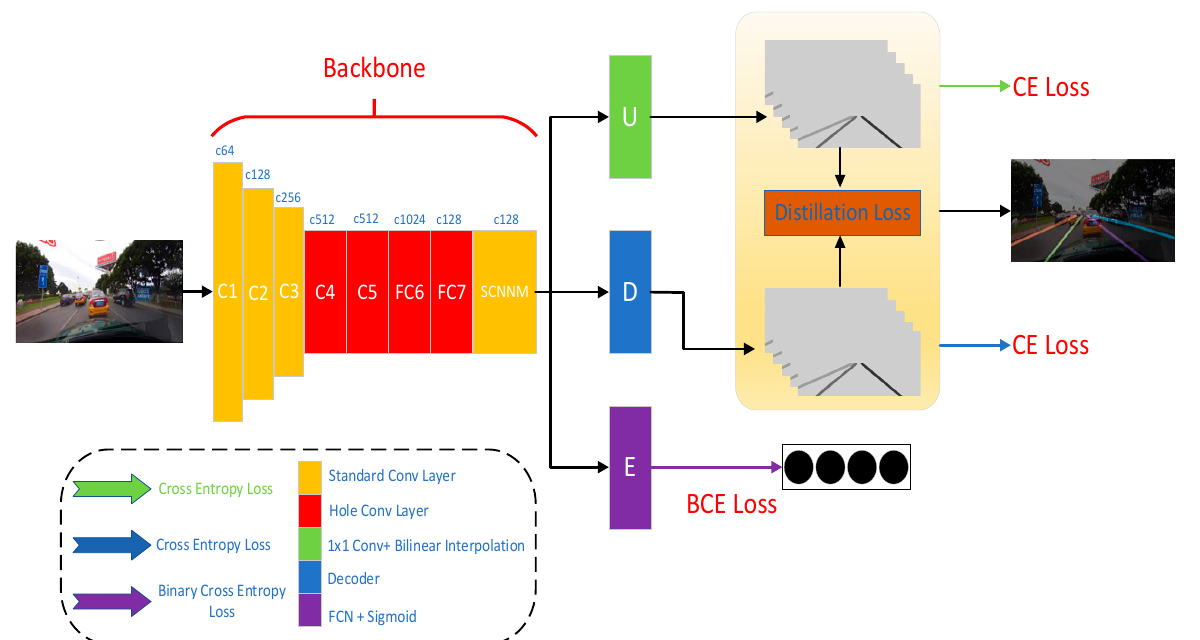
Figure 2. The overall block diagram of the target characteristic distillation network.